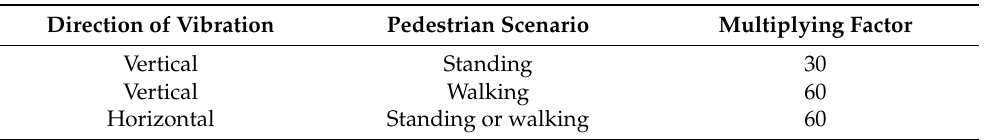
Figure 9. The vibration base curves for the RMS acceleration (ISO [42]): ( a ) the side-to-side and back-to-chest direction; and ( b ) the foot-to-head direction. Table 7. The multiplying factors used to specify the satisfactory magnitudes of footbridge vibration with respect to pedestrian responses (ISO